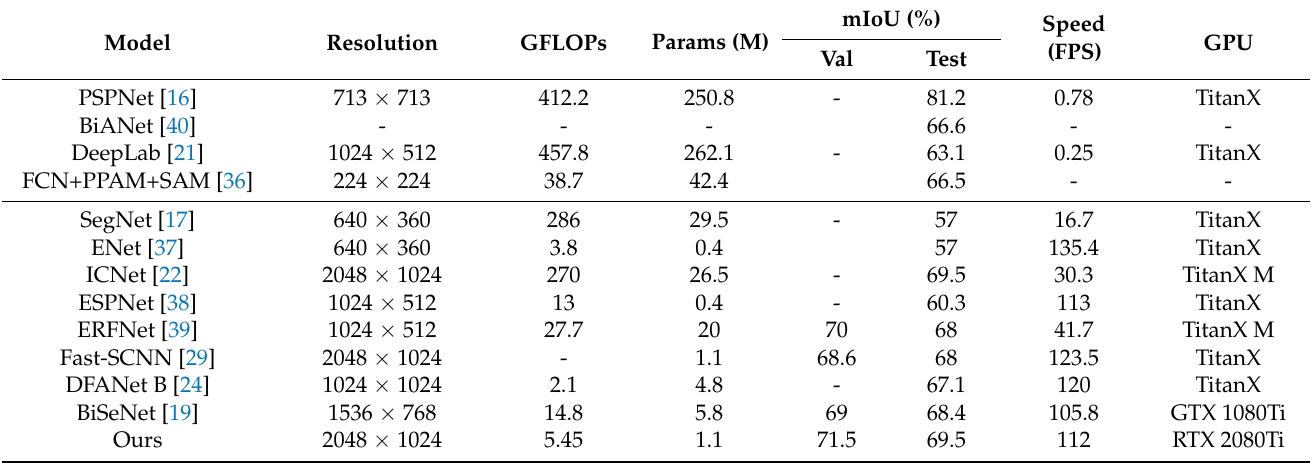
Table 2. Comparative results of accuracy vs speed on Cityscapes, including the results on both validation sets and test sets. We compare our method with other popular networks. We also report the test conditions, including Graphics Processing